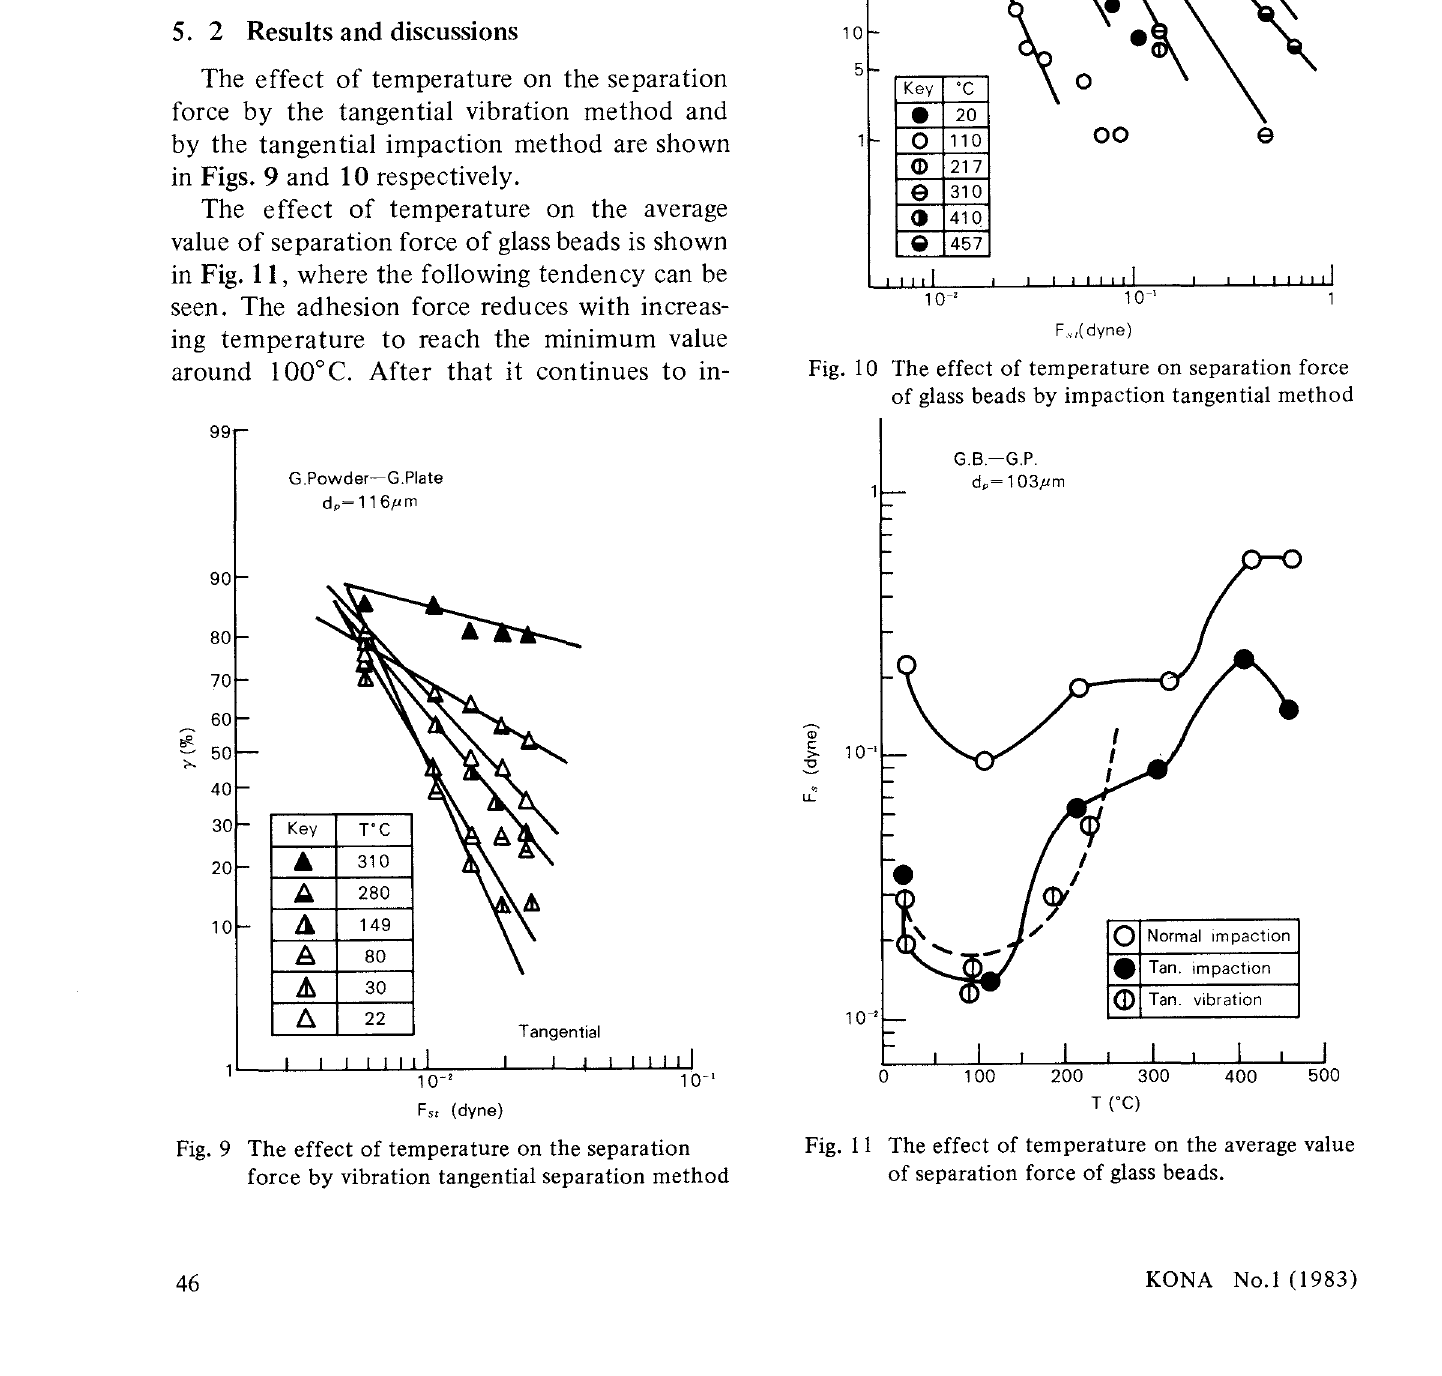
Fig. 11 The effect of temperature on the average value of separation force of glass